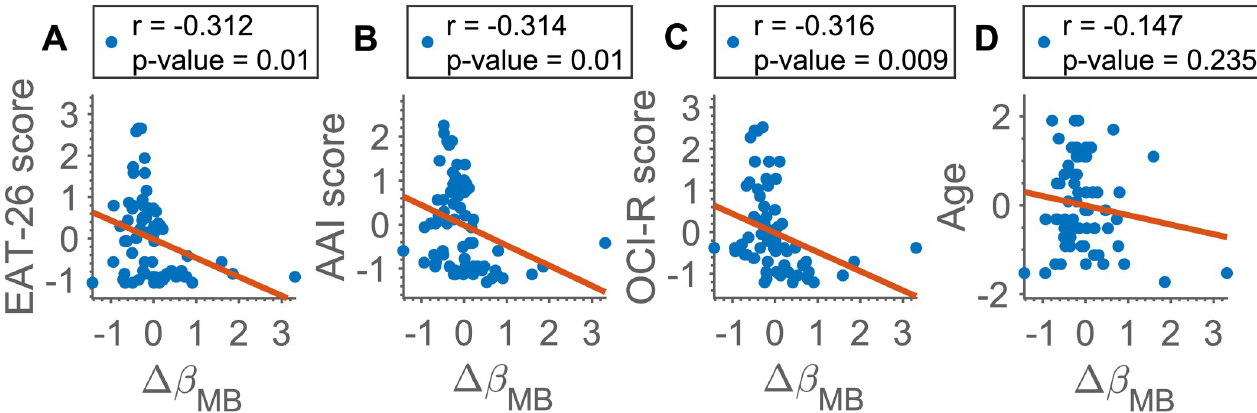
Fig 7. Correlation of EAT-26, AAI, OCI-R and age measurements (z-scored) with Δβ (r) and p-values are included.